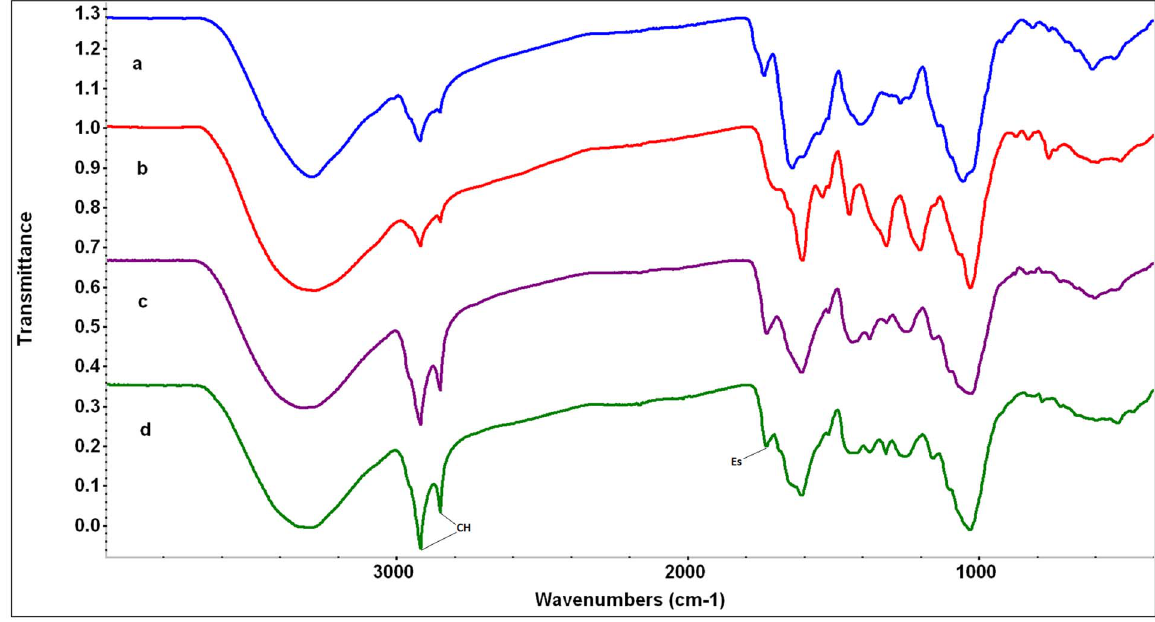
Figure 2. FTIR spectra of narrow gypsum endemisms. The scale of the Y axis is offset for illustration purposes. a) Centarurea hyssopifolia (blue), b) Helianthemum marifolium subsp. conquense (red), c) Teucrium pumilum (purple), d) Thymus lacaitae (green). Abbreviations of compound peaks: CH: CH-stretching, Es: Esters.